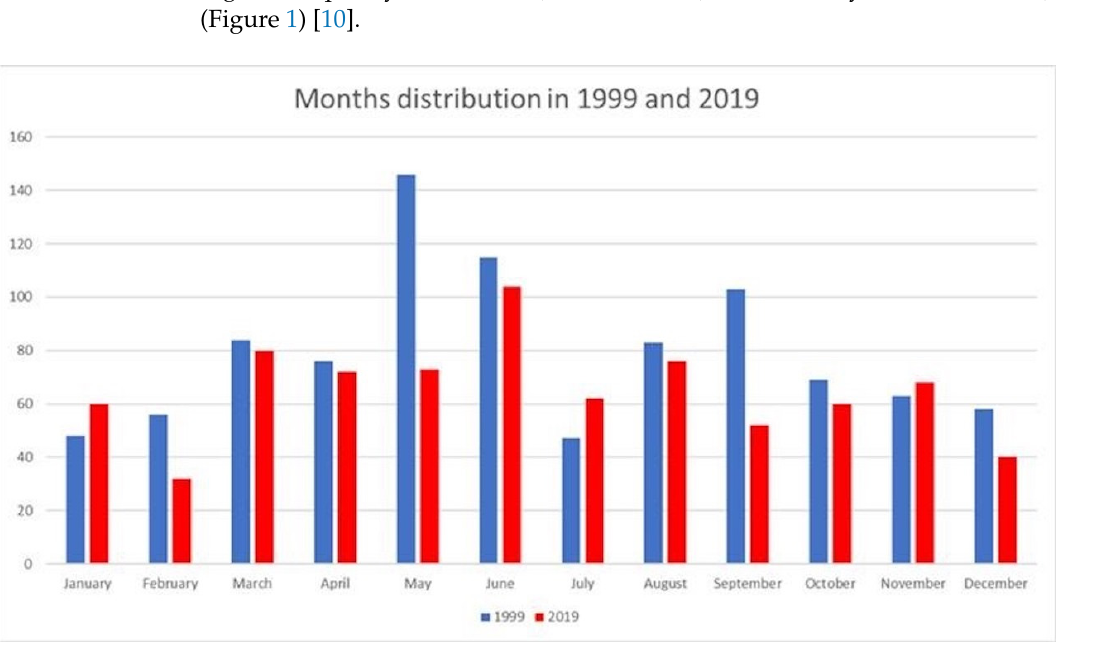
Figure 1. Breakdown of months in which fractures occurred in 1999 and 2019.